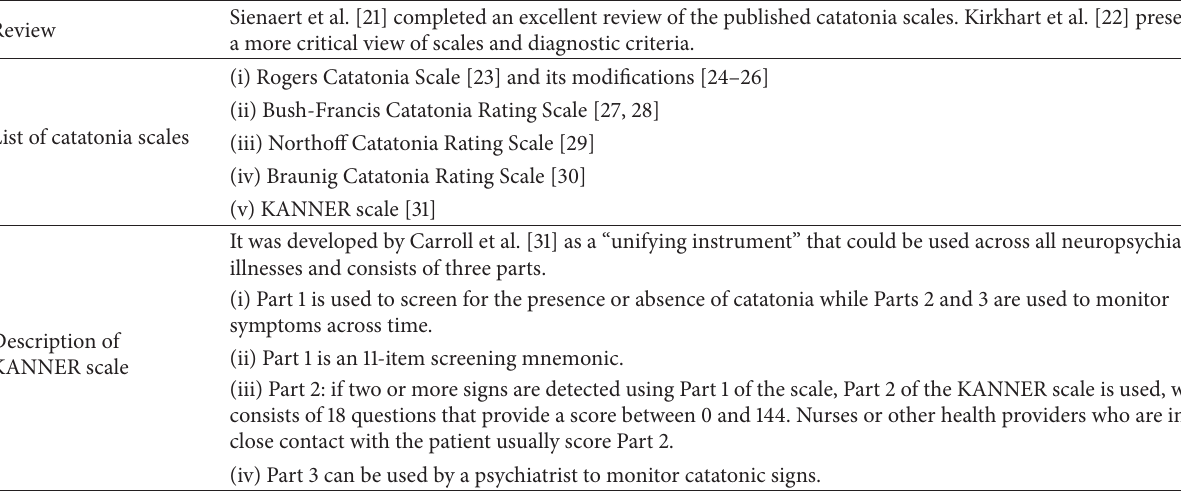
Table 2: Catatonia